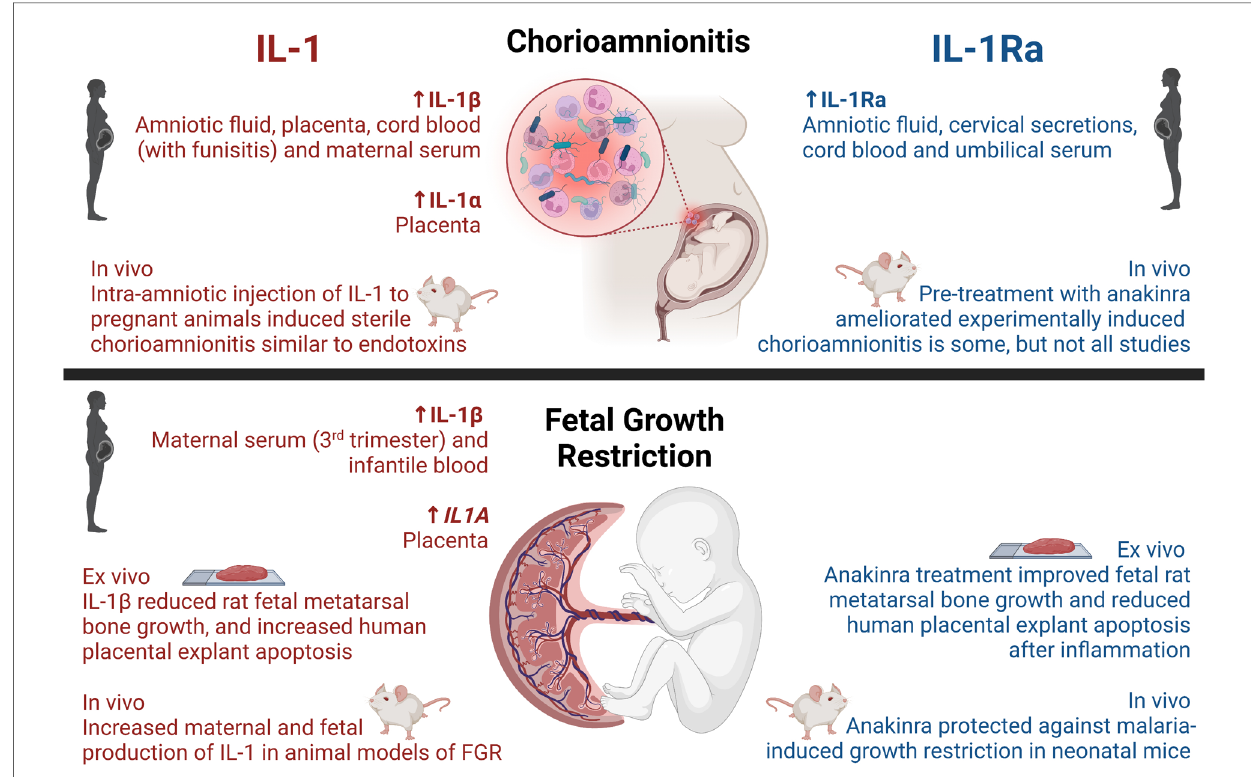
FIGURE 1 Reported activities of IL-1 and IL-1Ra on chorioamnionitis and fetal growth restriction in humans and disease models. Created with